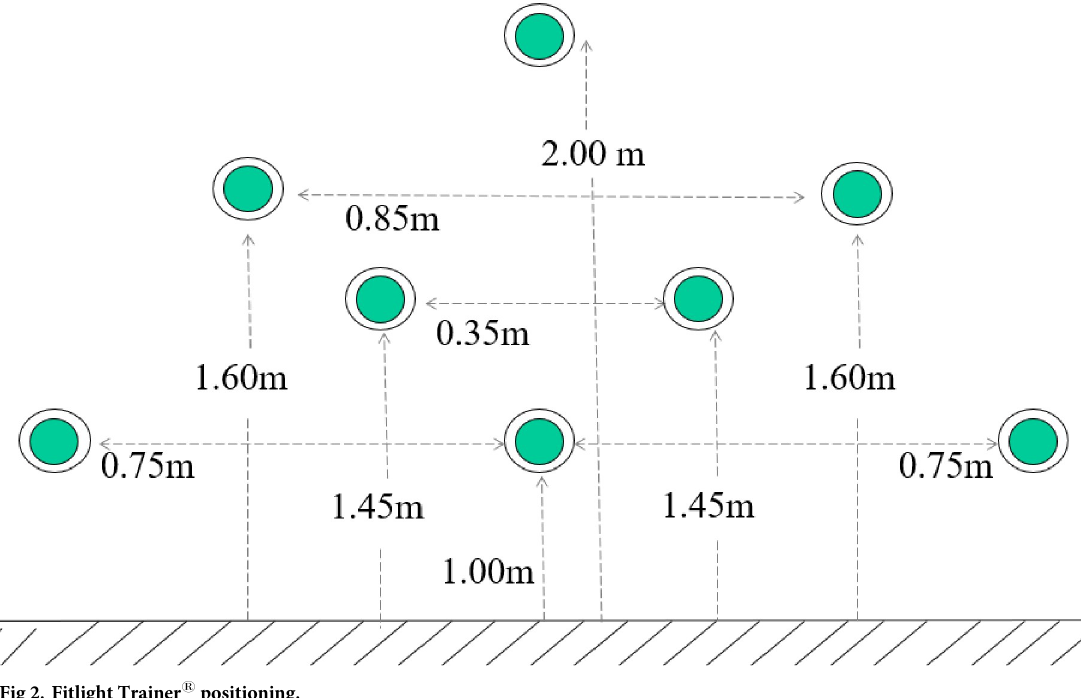
Fig 2. Fitlight Trainer 1